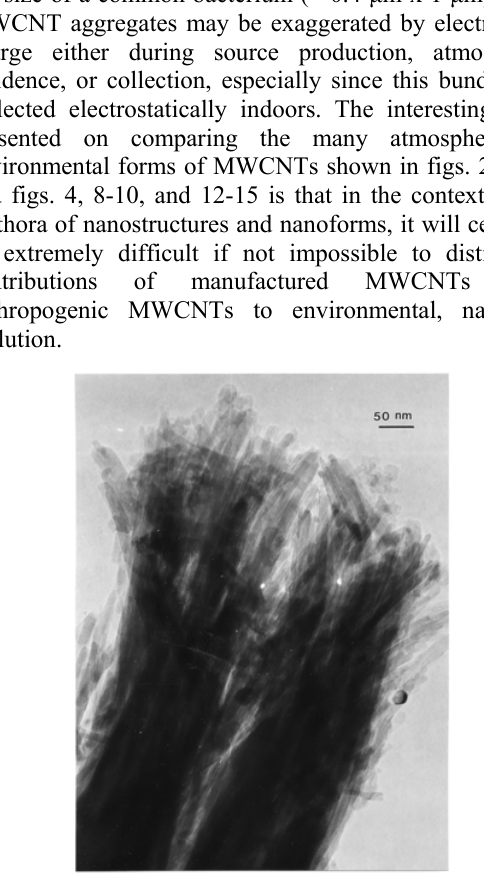
Figure 15: TEM image of MWCNT bundle collected indoors on an electrostatic